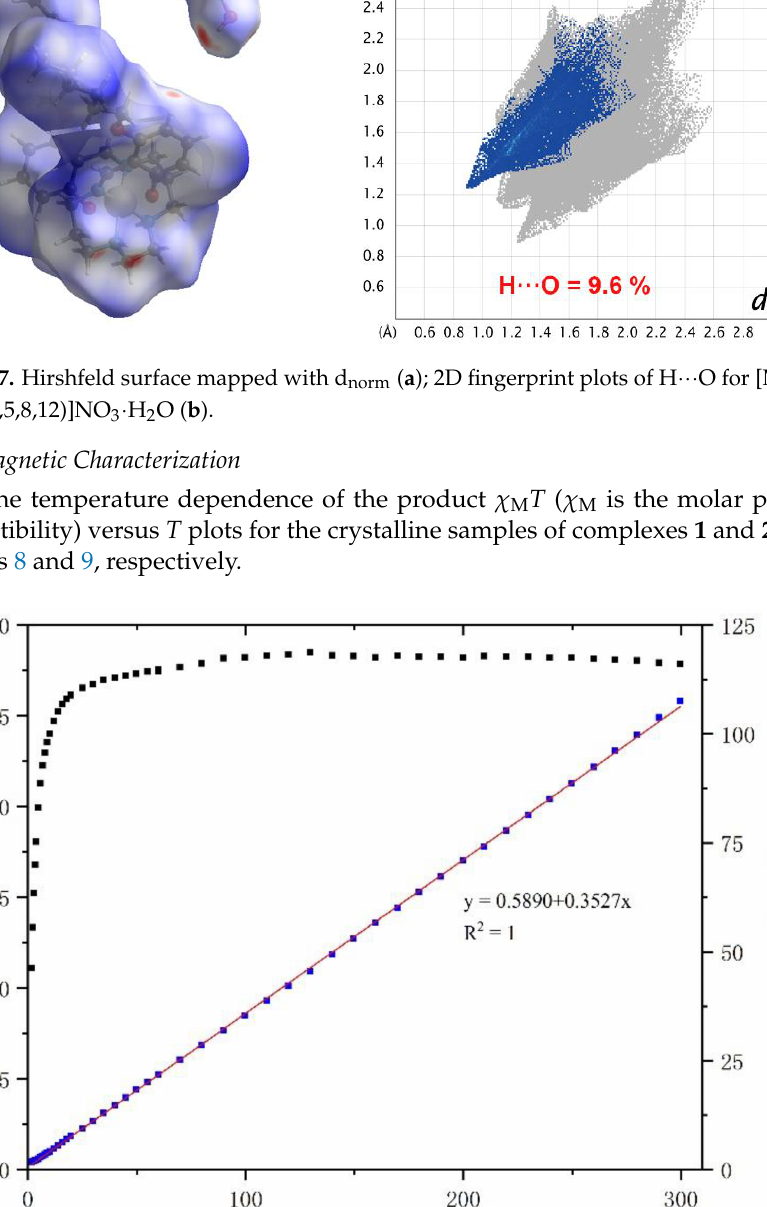
Figure 8. Temperature dependence of the χ M T of [Mn(4-OH-sal-N-1,5,8,12)]NO 3 between 2 and 300